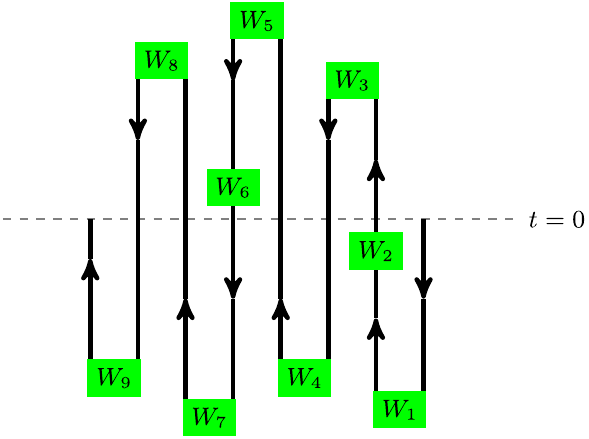
Fig. 11 Multifold echo with 2 ( k − 1 ) loops. Each green insertion rep- resents a tiny perturbation. The arrows point toward the order in which the precursors W i ’s apply